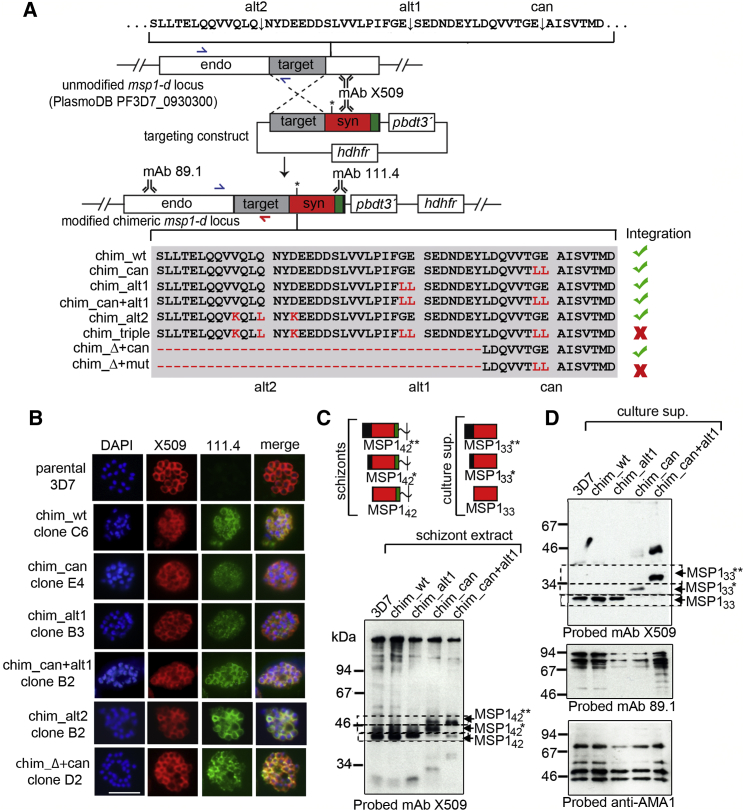
Mutations that Prevent All Processing in the 38/42 Region Are Deleterious(A) Top: modification of the P. falciparum msp1-d locus by single-crossover homologous recombination. The targeting region (gray) incorporated into the integration constructs was fused just upstream of the 38/42 region to recodonized sequence (red/green, syn) encoding the rest of the ORF. In all except pHH1MSP1chim_wt, this incorporated mutations and/or deletions to block processing at one or more 38/42 cleavage sites (asterisk). The 3′ end of the recodonized sequence (green) contained the MSP1-F-specific mAb 111.4 epitope. Positions of hybridization of primers used for diagnostic PCR are indicated (blue and red half arrows). Integration replaced the msp1 3′ UTR with that of the P. berghei dihydrofolate reductase gene (pbdt). The hdhfr cassette confers resistance to WR99210. Integration produces a modified locus encoding a chimeric MSP1 recognized by both mAb X509 and mAb 111.4. Bottom: substitutions or deletions (hyphens) introduced by the constructs are indicated (red). Green tick, successful integration. Red cross, no integration detected.(B) IFA of schizonts of the parental and transgenic P. falciparum clones. All transgenics reacted with mAb 111.4. Scale bar, 5 μm.(C) Top: schematic of the MSP142 fragment (GPI anchored) and the slightly larger MSP142∗ and MSP142∗∗ species predicted to result from ablation of cleavage at the canonical and canonical plus 38/42alt1 sites, respectively. The MSP133 and modified MSP133∗ and MSP133∗∗ fragments, derived from cleavage by SUB2 within MSP142, MSP142∗, and MSP142∗∗, respectively, are also depicted. Bottom: western blot shows differences (highlighted, dotted lines) in migration of the wild-type and modified MSP142 forms.(D) Western blot of culture supernatants shows differences in migration of MSP133, MSP133∗, and MSP133∗∗ (highlighted as above). As controls, supernatants were probed with mAb 89.1, which recognizes MSP183, or antibodies to an irrelevant shed parasite protein, AMA1. See also Figure S3.